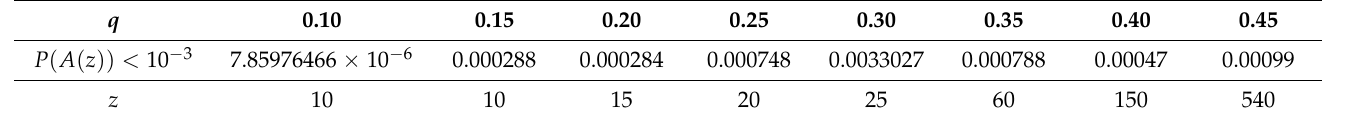
Table 2. Minimal numbers of confirmation blocks for different adversary